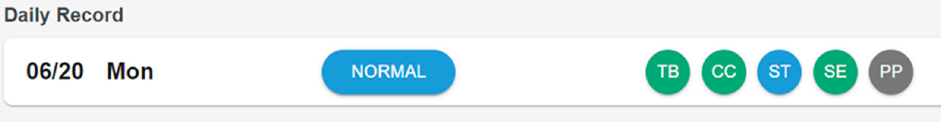
Figure 6. Dashboard for overall status.